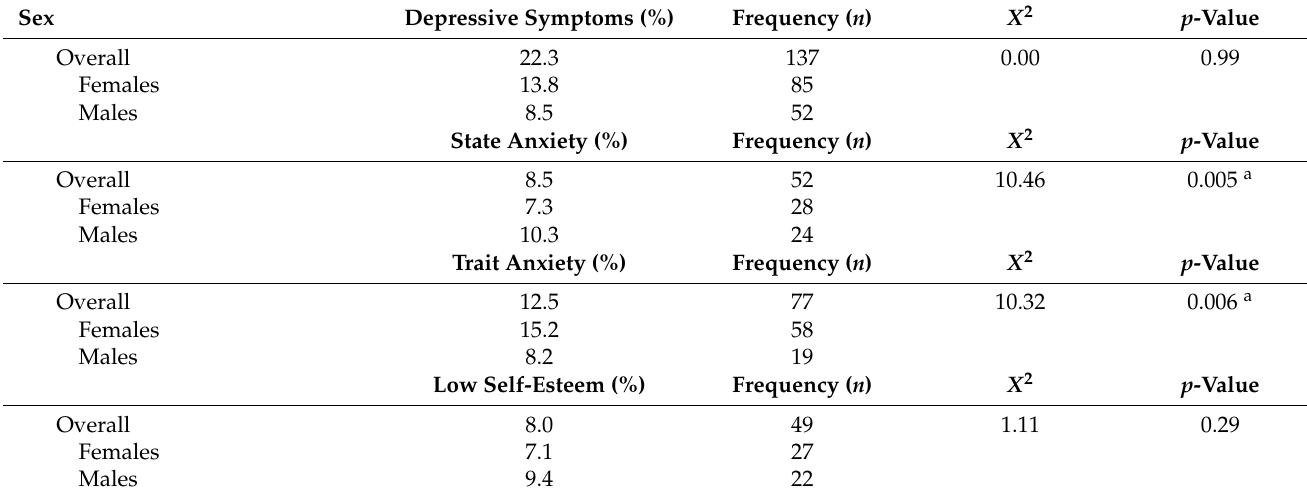
Table 2. Depression, Anxiety and Low Self-Esteem Prevalence Rates by Sex.